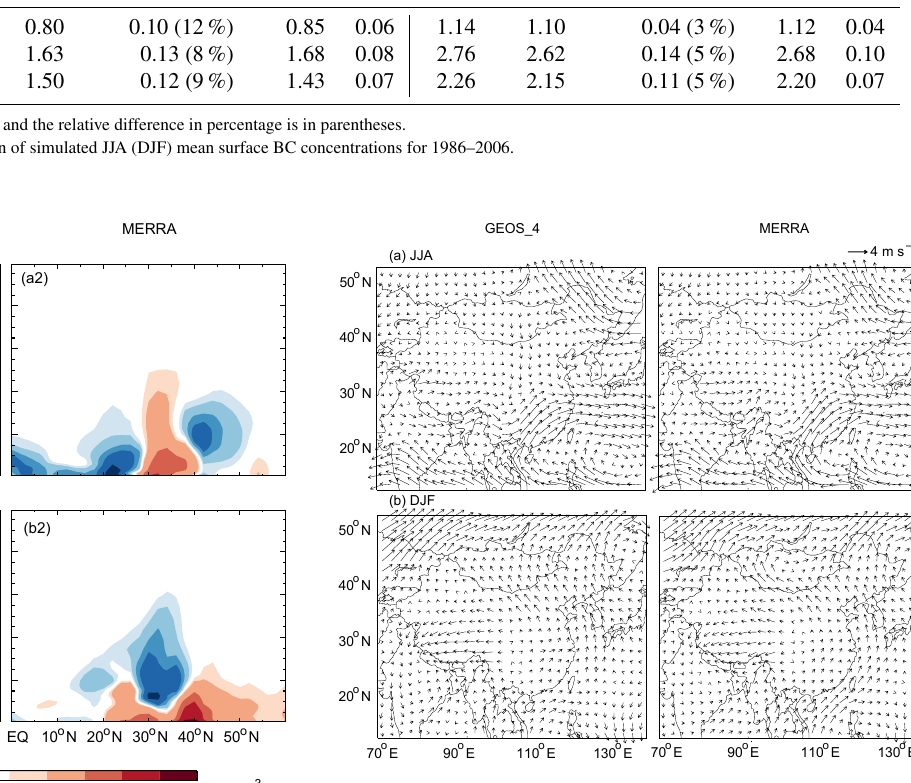
Figure 6. (a) Differences in JJA 850hPa wind (vector, ms − 1 ) be- tween the 5 weakest and 5 strongest EASM years during 1986–2006 from GEOS-4 (left) and MERRA (right) data. (b) Same as panel (a) , but for differences in DJF wind between 5 weakest and 5 strongest EAWM